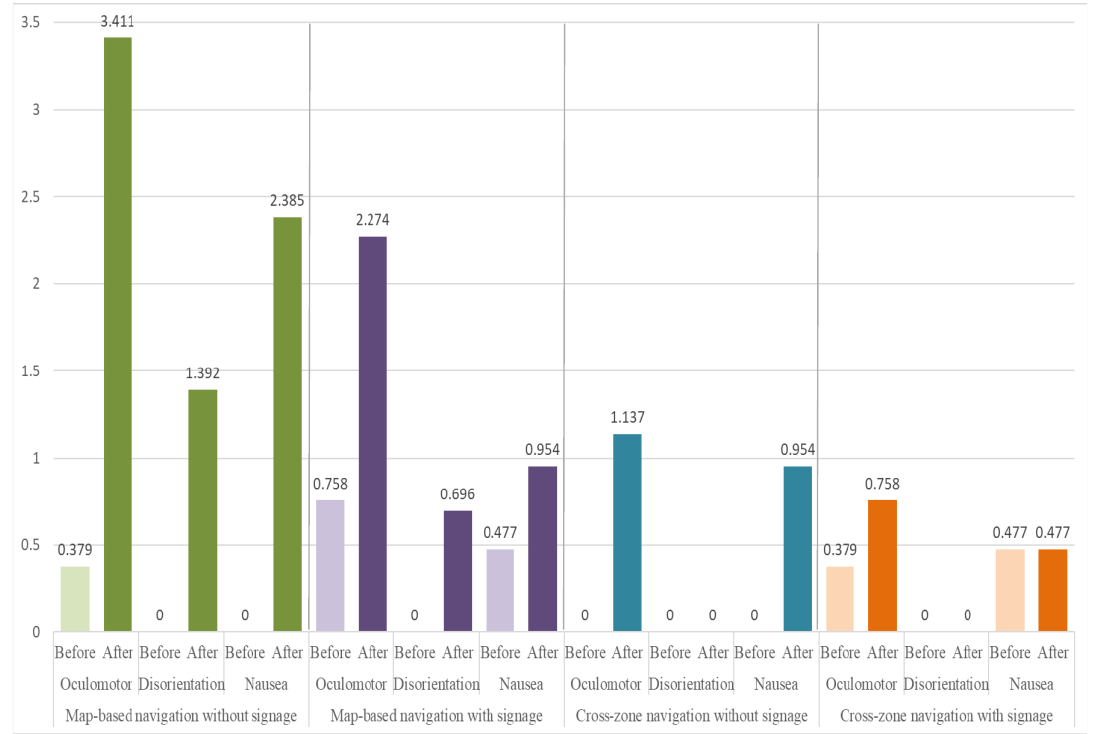
Figure 12. The average SSQ subscores of different system combinations on three distinct symptom clusters (oculomotor, disorientation, and nausea).